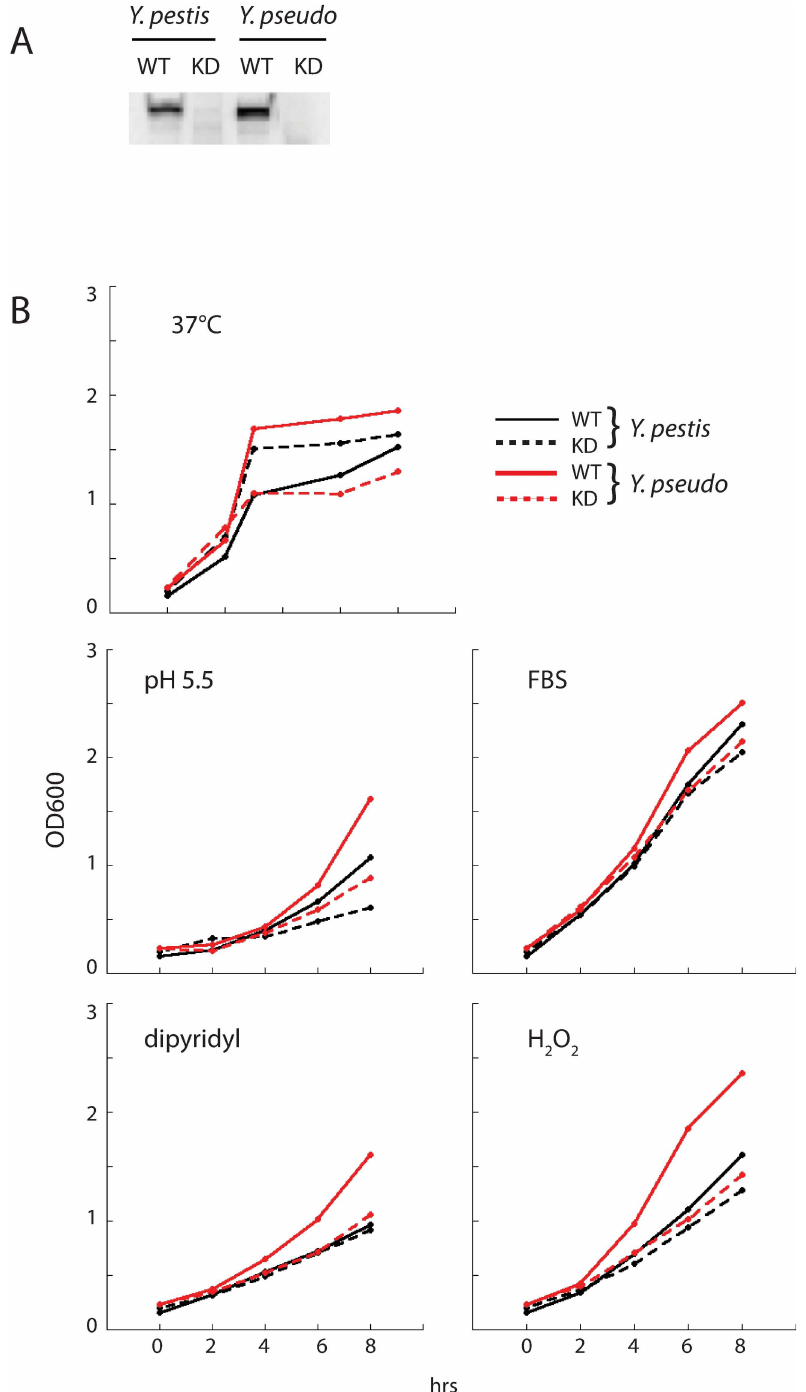
Fig 3. Analysis of KD Ysr170 strain. (A) Total RNA was isolatedfrom wild-type(WT) and knock-down (KD) strains of Ysr170 in Y . pestis and Y . pseudotuberculosis , and Ysr170 expressionwas analyzedby northern blot. (B) Growth curves of Y . pestis (black lines) and Y . pseudotuberculosis (red lines) wild-type(solid) and Ysr170 KD (red) strains were examinedin responseto different stress conditionsup to 8 hrs at 2 hr intervals. Stress conditionsincludetemperature (37˚C), mild acidity (pH 5.5), host serum (10% FBS), iron starvation (100 μ M2,2’-dipyridyl), and oxidativestress (1mM H 2 O 2 ). A representative experimentfrom three independent experiments is